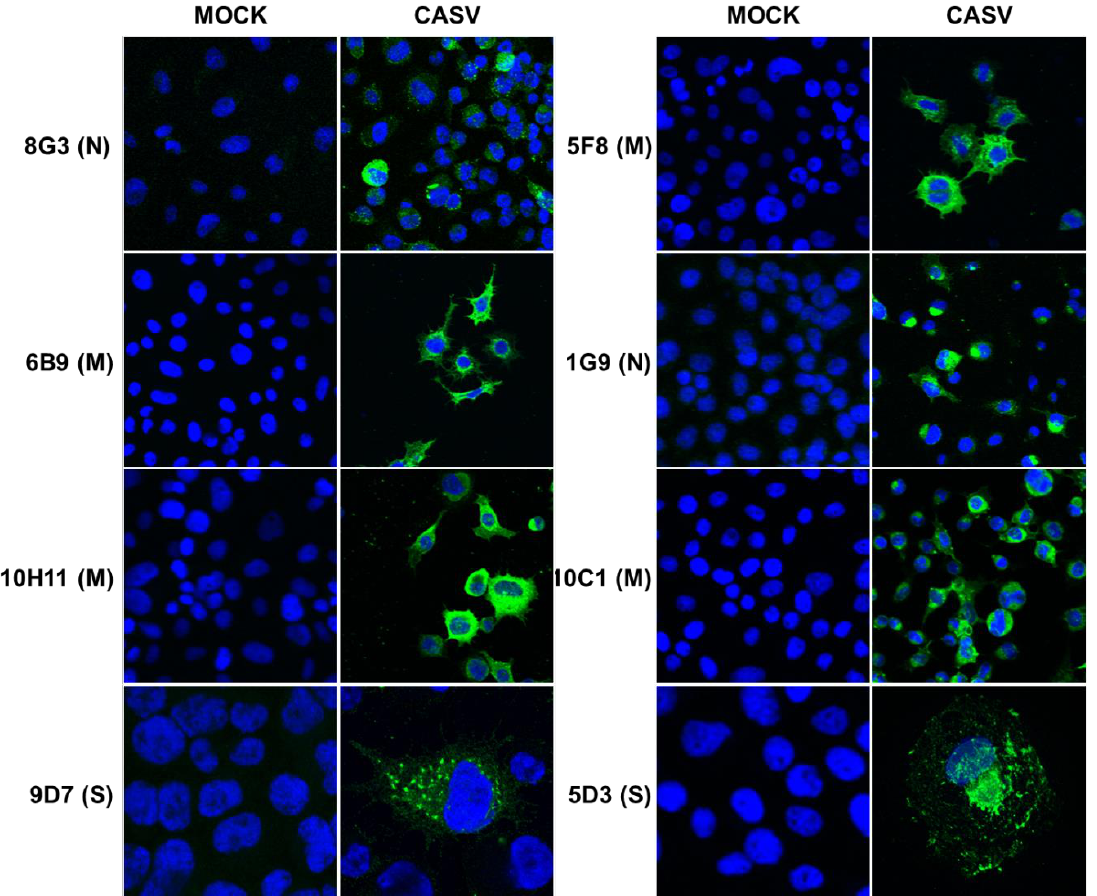
Figure 3. IFA analysis by confocal microscopy of CASV mAbs. Antibodies recognising each viral protein (S, M and N) were used to stain fixed CASV-infected C6/36 cells. Viral antigen in green and cell nuclei were stained with Hoechst 33342 in blue. Slides were imaged at 20× magnification, panels 5D3 and 9D7 imaged at 63×.